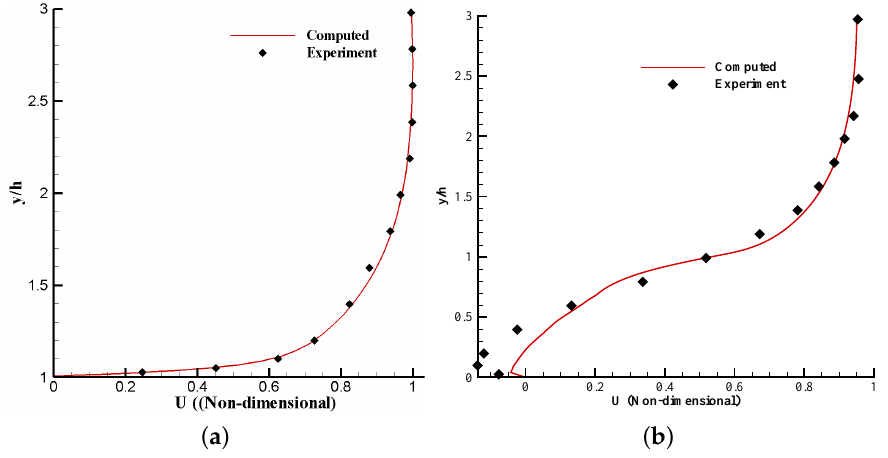
Figure 16. Mean velocity profiles for a 2D backward facing step. ( a ) Velocity profile at x / h = − 3.12; ( b ) Velocity profile at x / h =